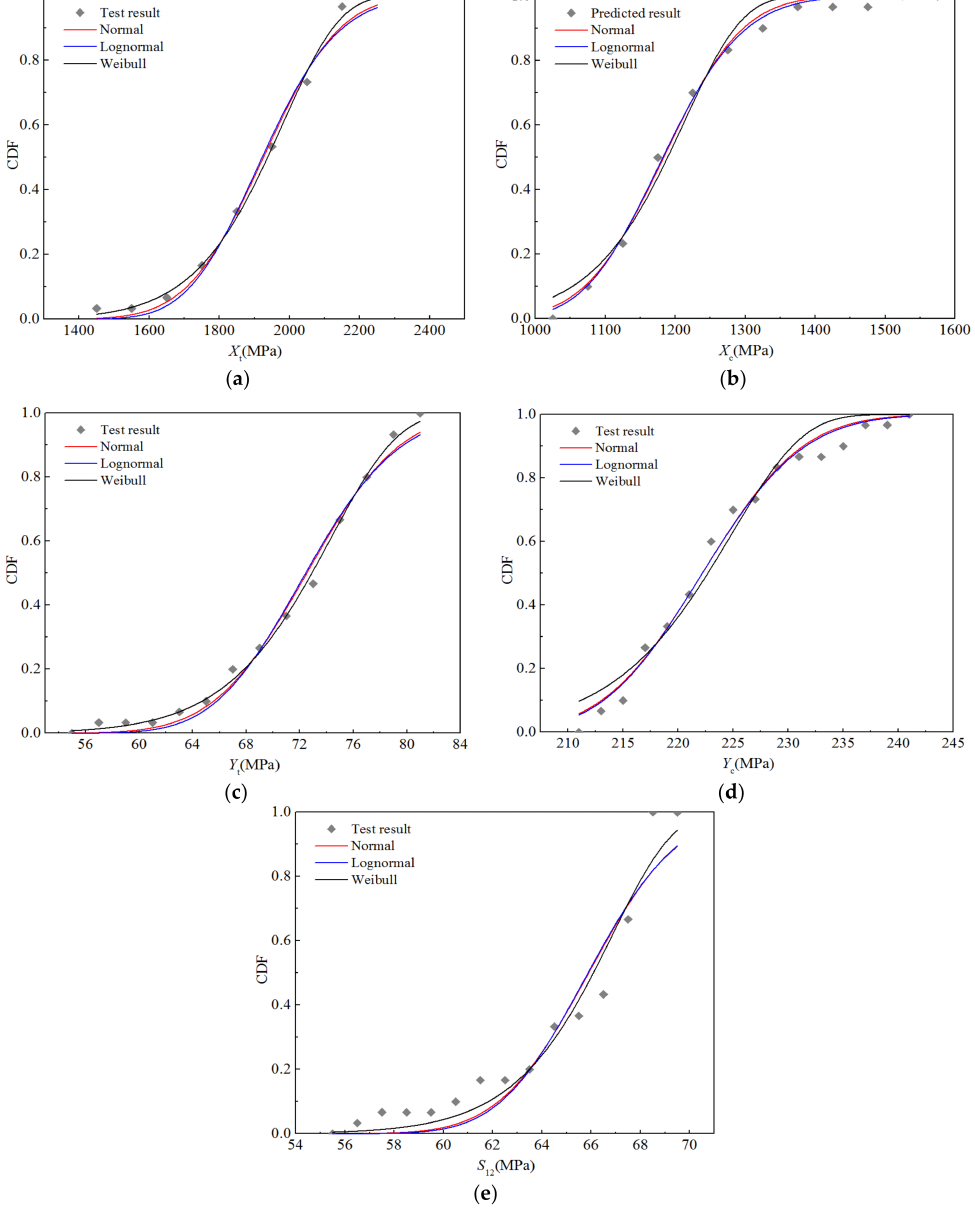
Figure 8. Fitting curves for the strength performance functions of H-GFRPs at RT. ( a ) X t , ( b ) X c, ( c ) Y t , ( d ) Y c, ( e ) S 12